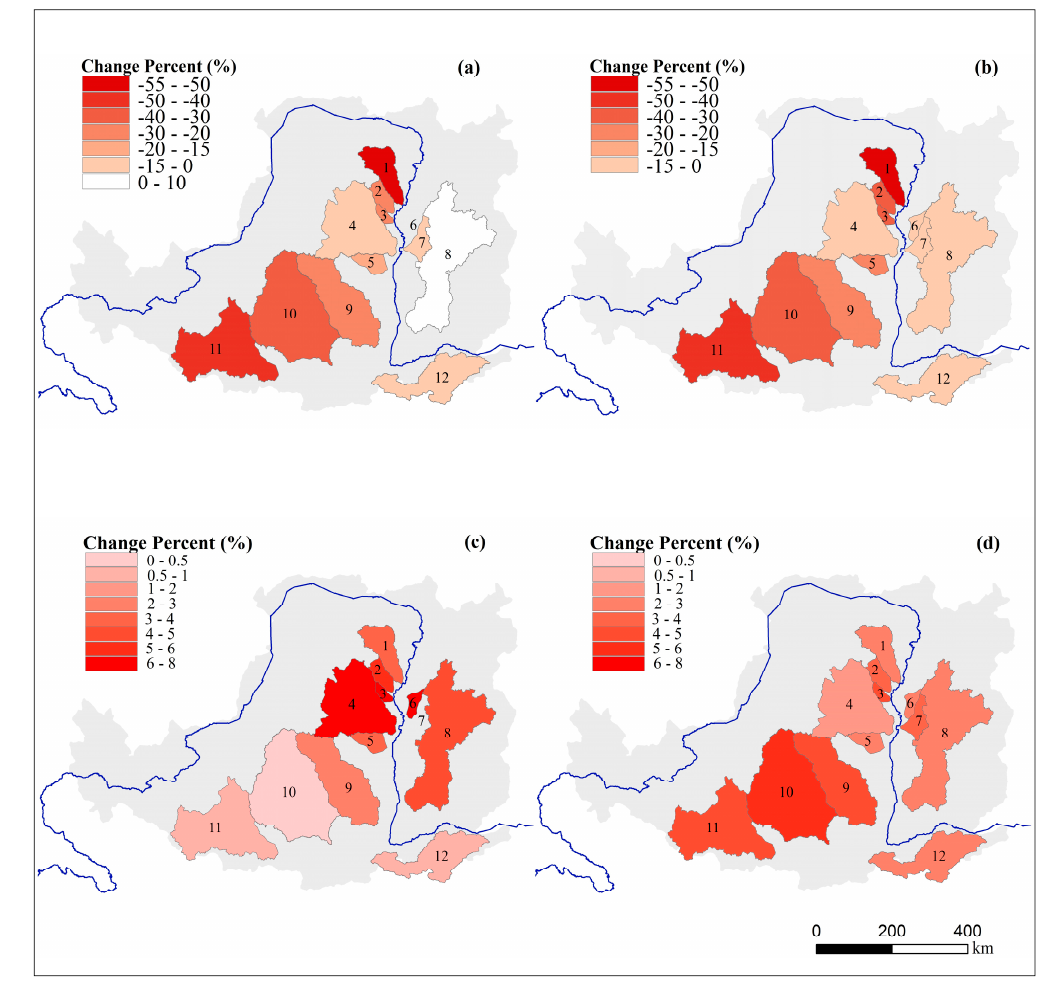
Figure 2. Spatial distribution of the percentage decrease (%) in naturalized runoff ( a ); the runoff coefficient ( b ); precipitation ( c ); and potential evapotranspiration ( d ) between 1980–1999 and 2000–2013.